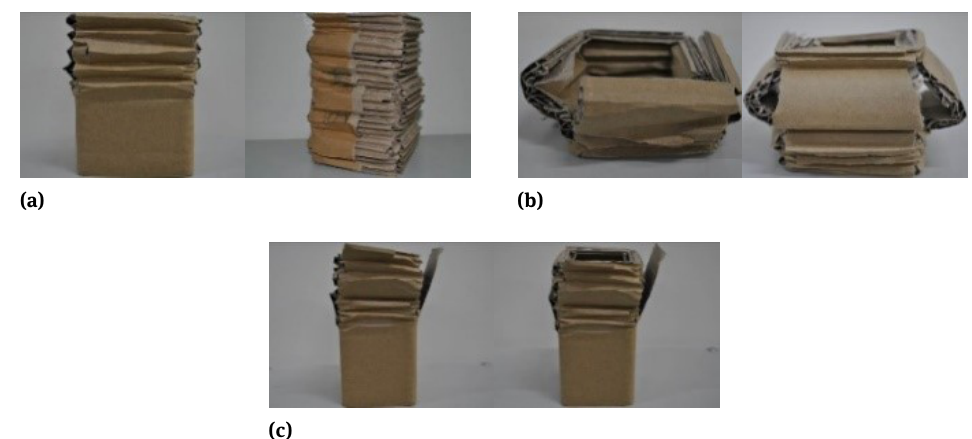
Figure 1: Deformation modes of X-direction paper corrugation tube: (a) accordion deformation, (b) corner tearing deformation and (c) transverse shear deformation